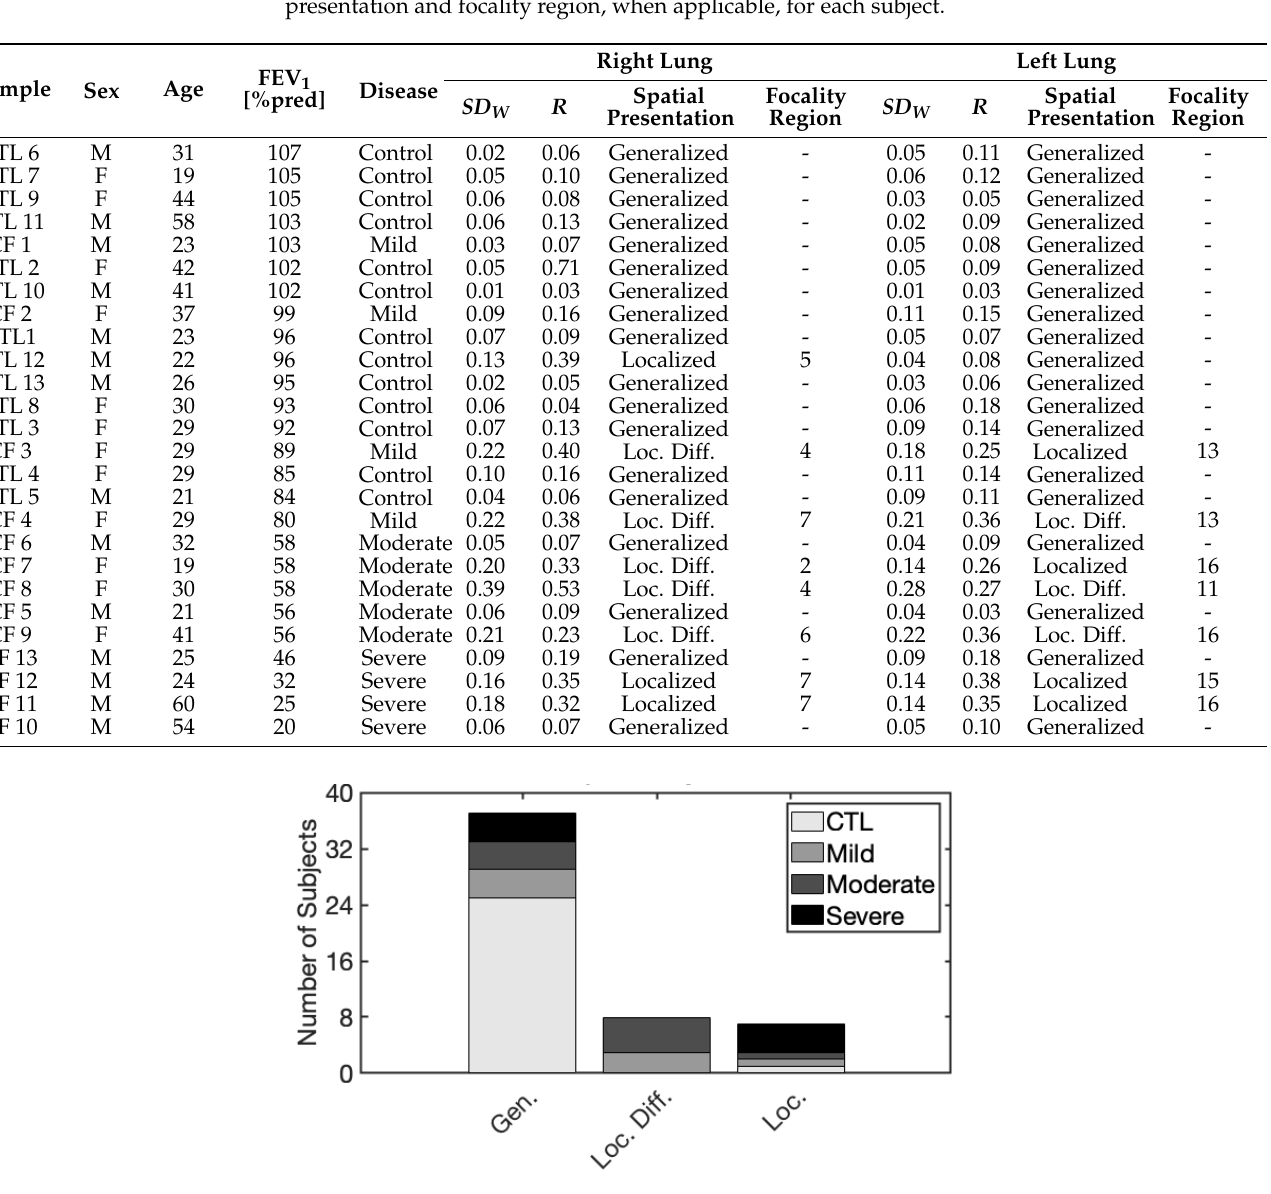
Table 3. Subject demographics, FEV 1 , and spatial presentation assignments. Category of spatial presentation and focality region, when applicable, for each subject.